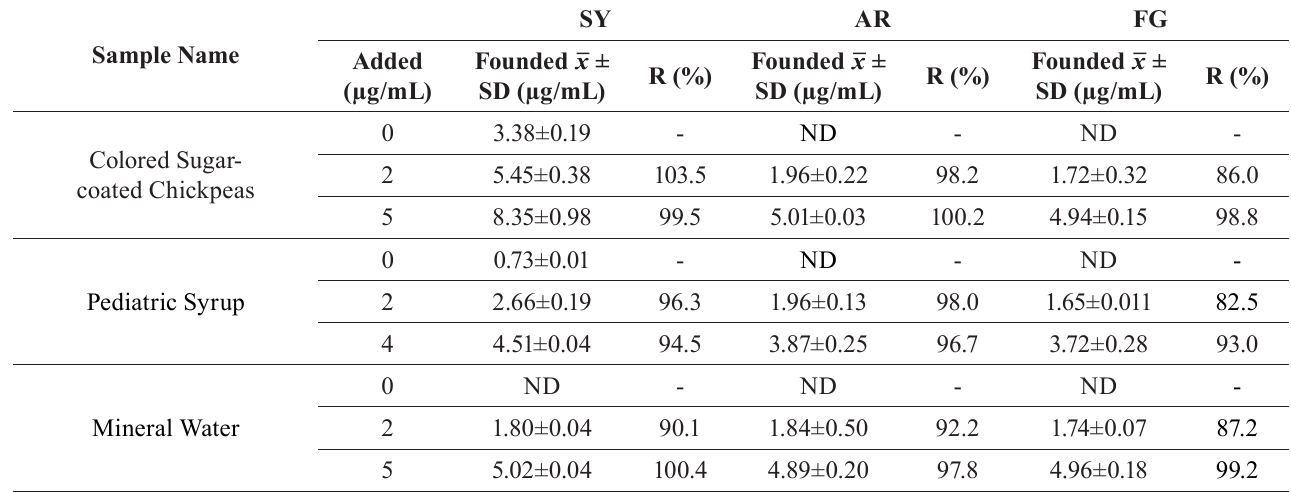
(6/4, v/v); 100 mg Fe 3